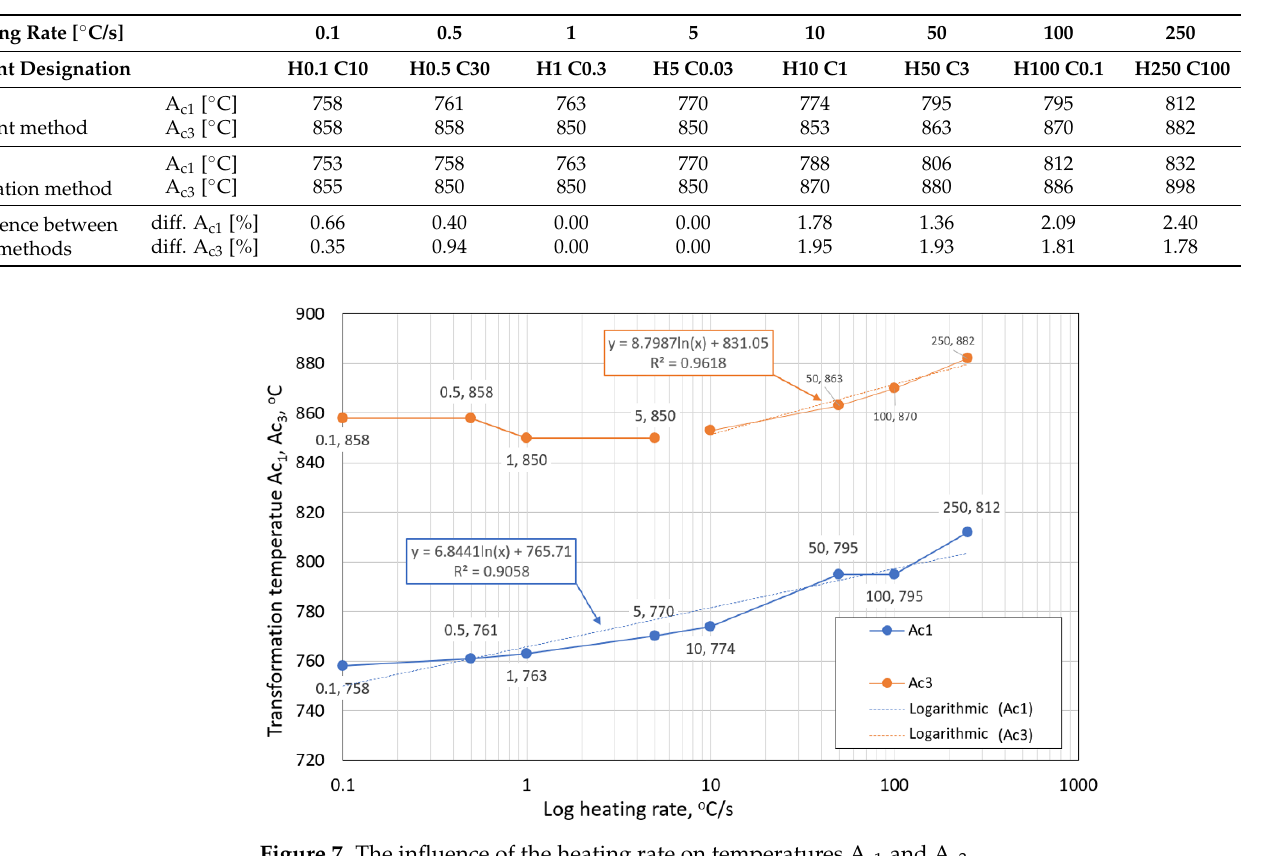
Table 6. The effect of the heating rate on shifts in the transformation temperatures A c1 and A c3.